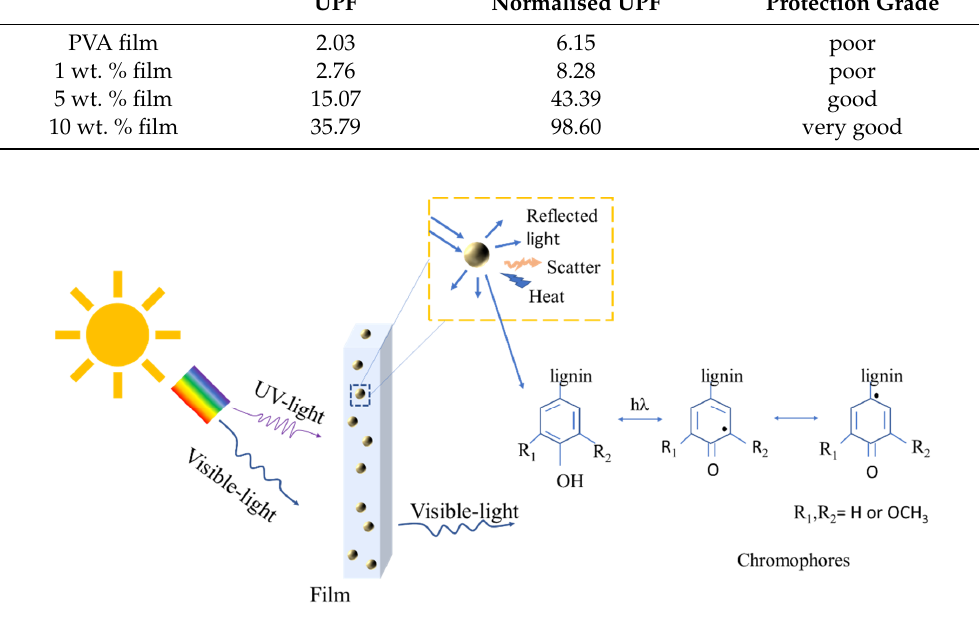
Figure 9. The proposed mechanism of UV shielding performance of hemp/PVA film.